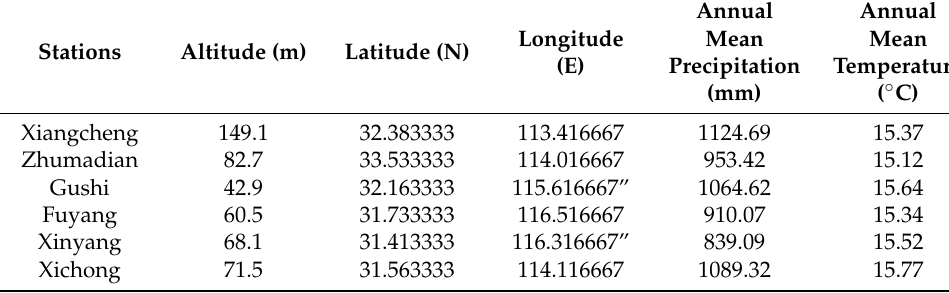
Table 1. List of representative Meteorological stations’ information.